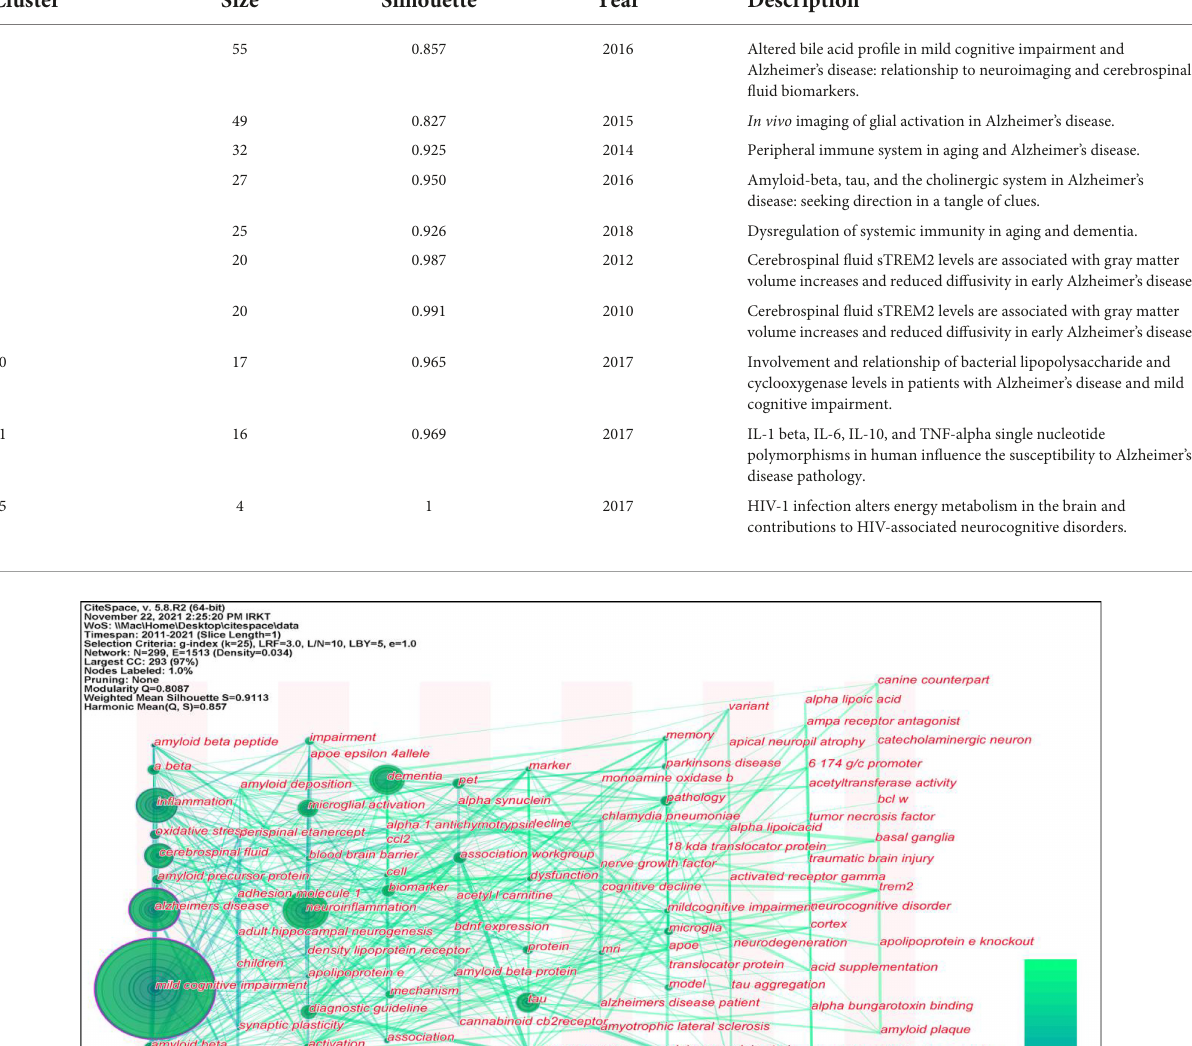
TABLE 6 Research frontier identification.